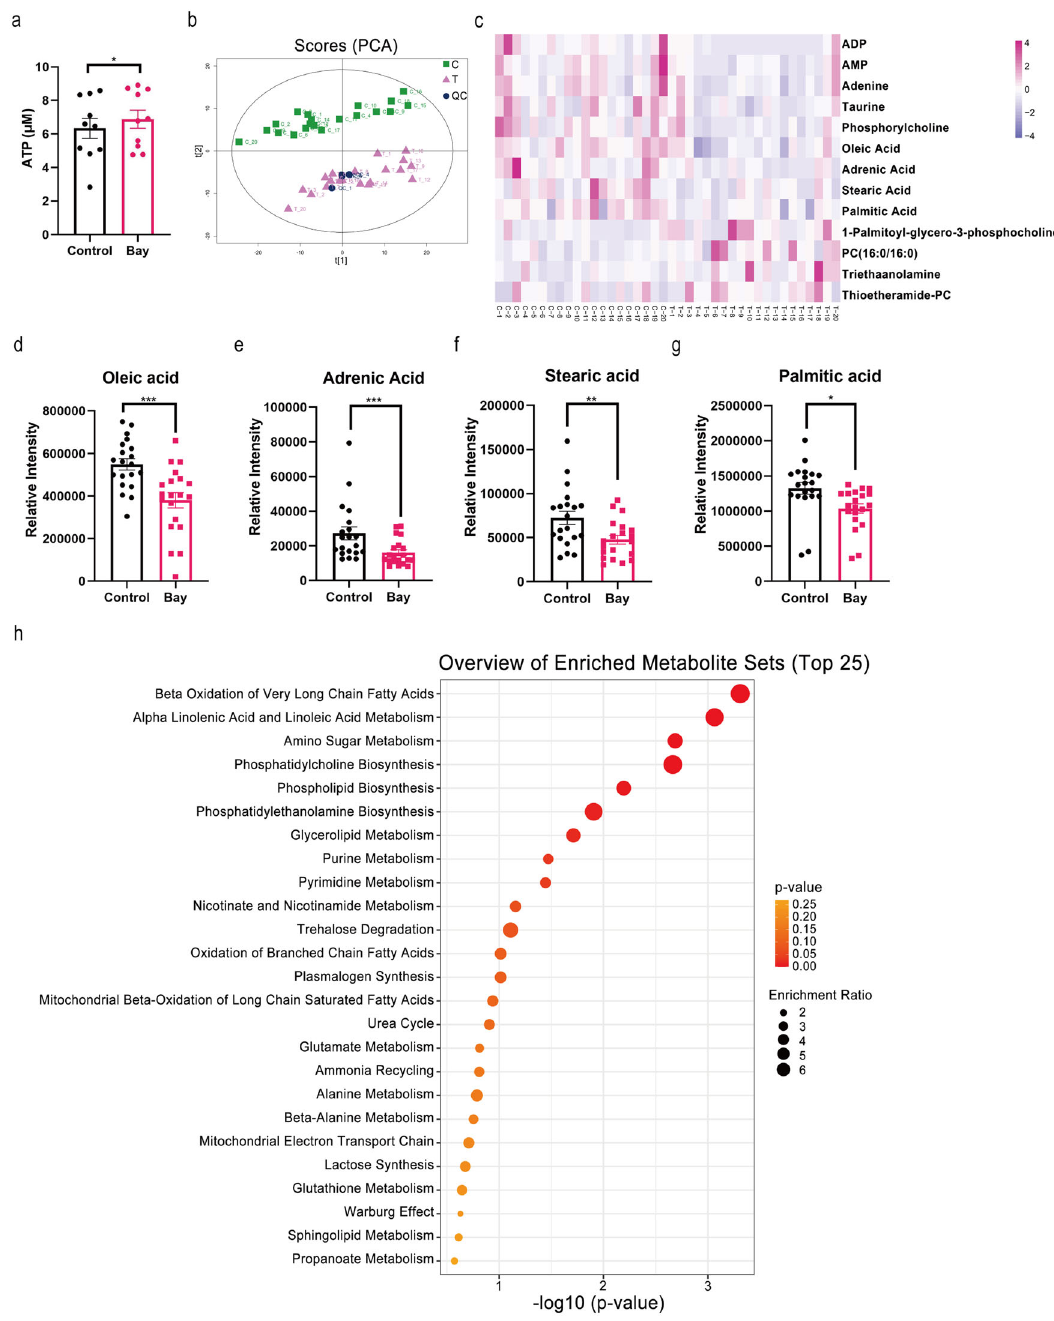
Fig. 4 Bay117082-induced sperm motility enhancement consumes fatty acids as the energy source. a Effects of 25 μ M Bay117082 on sperm ATP level. Values represent mean ± SEM ( n = 10), * p < 0.05, as compared with the control (0 μ M). b Principal component (PCA) analysis of untargeted metabolomics data obtained from Bay117082-treated sperm and control sperm. Each dot on plot represents an individual sample ( n = 20). Green dots represented the control group (C); purple dots represent the Bay117082-treated group (T); blue dots represent the quality control samples. c Heatmap of signi fi cantly different metabolites in the control (C) and Bay117082-treated (T) group. The variable importance in the projection (VIP) value of each variable in the orthogonal partial least squares discriminant analysis (OPLS-DA) model was calculated. Signi fi cance was determined using paired Student ’ s t test. VIP > 1 and p < 0.05 were applied to identify statistically signi fi cant differential metabolites. The x -axis represents comparative changes in each sperm sample before (C1 – C20) and after (T1 – T20) Bay117082 treatment. Signi fi cantly different metabolites were labeled on the y -axis. d – g Bay117082- induced changes in oleic acid ( d ), adrenic acid ( e ), stearic acid ( f ), and palmitic acid ( g ) in sperm. Values represent mean ± SEM ( n = 20), * p < 0.05; ** p < 0.01; *** p < 0.001, as compared with the control (0 μ M). h Metabolite Set Enrichment Analysis based on the Small Molecule Pathway Database. The top 25 of enriched pathways are